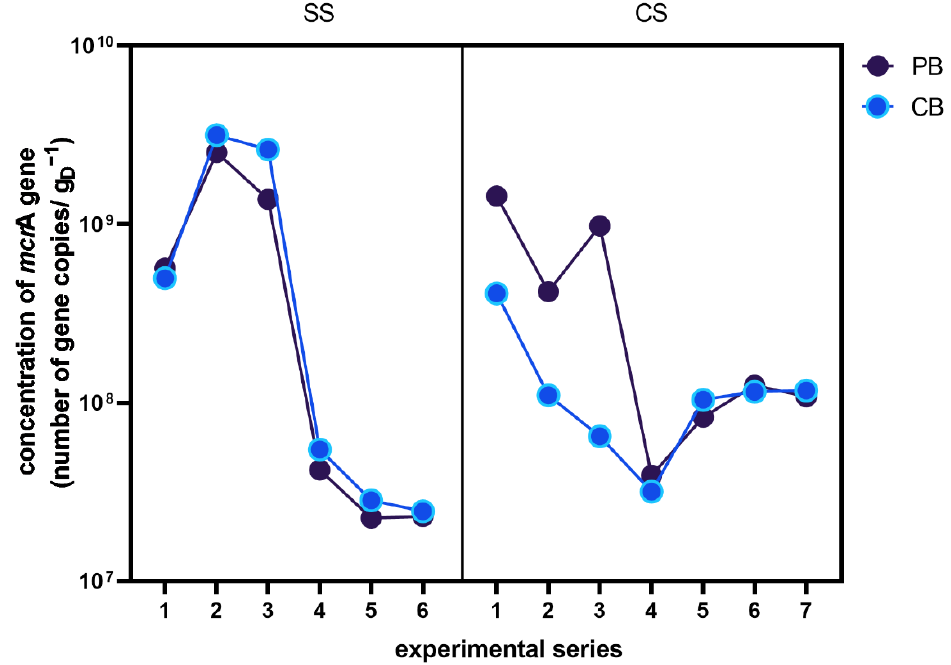
Figure 2. Prevalence of the mcr A gene in sewage sludge (SS) and cattle slurry (CS) samples from process (PB) and control bioreactors (CB). The mean values noted in each experimental series were used.